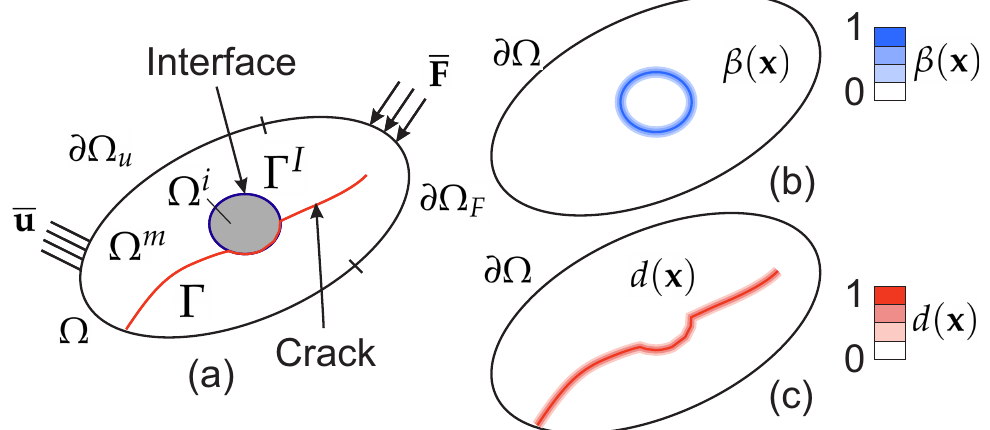
Figure 2. ( a ) cracked structure: boundary conditions and sharp description of cracks and interfaces; ( b ) smoothed description of the interfaces through the field β ( x ) ; ( c ) smoothed description of cracks through the field d ( x )